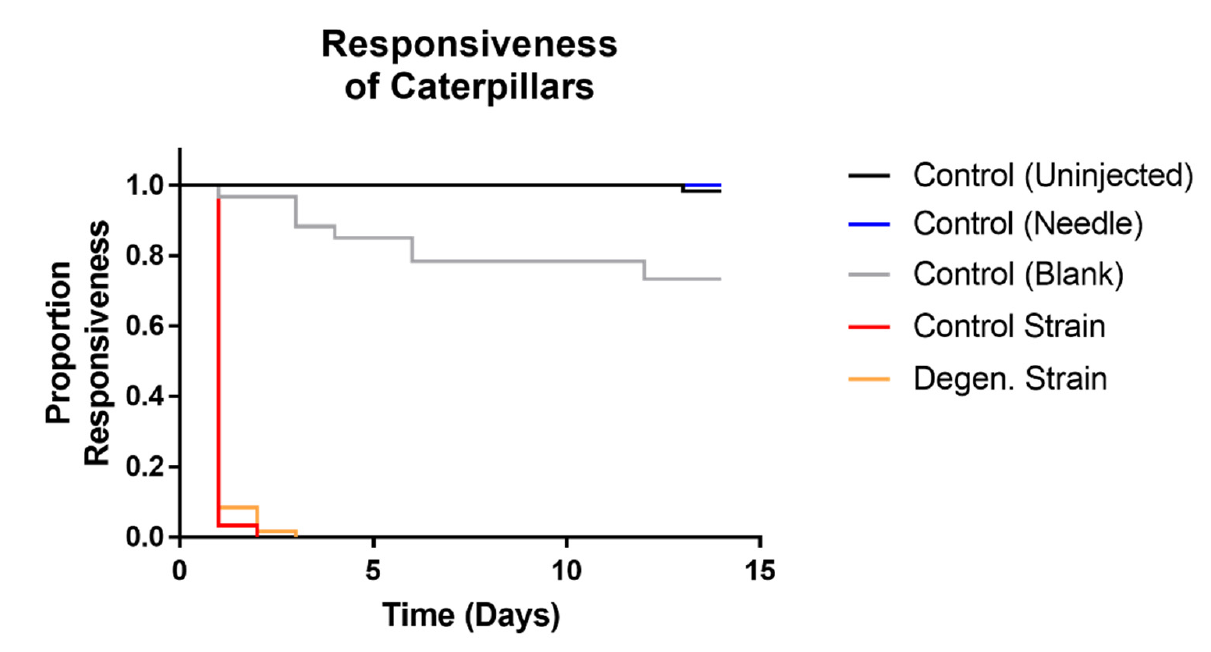
Figure 8. Kaplan Meier plot showing responsiveness observed in Galleria mellonella caterpillars following injections with C. militaris conidia and media from PBD cultures. Responsive caterpillars showed self-movement when disturbed individually using tweezers. Results were recorded on a daily basis over a period of two weeks, following injection with media and conidia from CM2 potato dextrose broth cultures, as well as controls. Sixty caterpillars were used in each treatment.